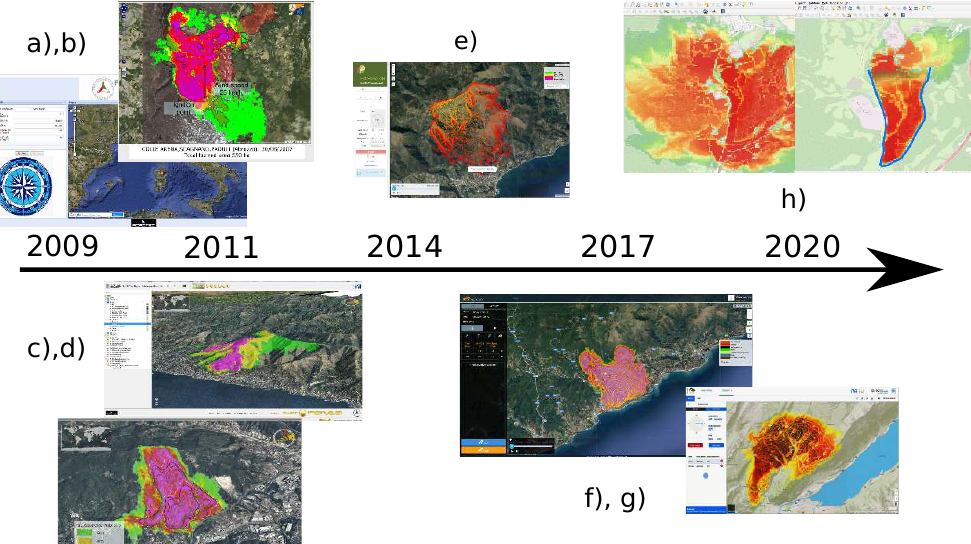
Figure 1. The roadmap of operational PROPAGATOR implementation, from 2009 to 2020. Each letter represents a milestone in the development of the project, explained in detail in the main text.